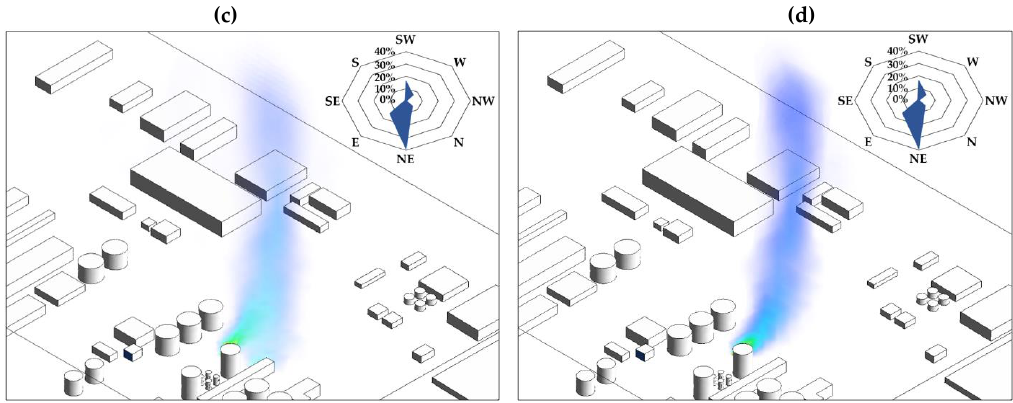
Processes 2021 , 9 , x FOR PEER REVIEW Figure 2. Changes in HF three-dimensional concentration distribution with time when the wind speed is 4 m/s: ( a ) t = 60 s; ( b ) t = 240 s; ( c ) t = 420 s; ( d ) t = 600 s.